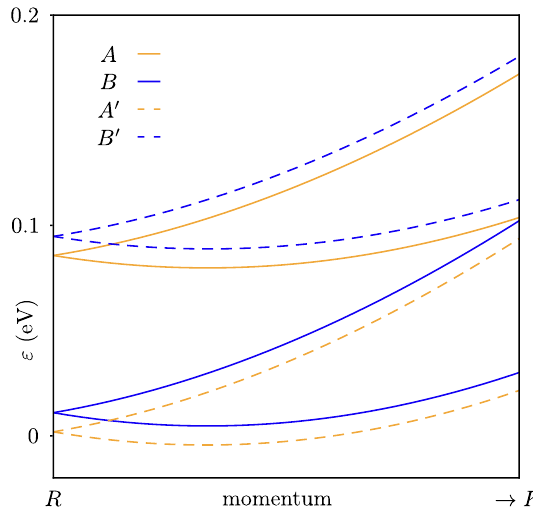
Figure 7: Band structures obtained from the Wannier Hamiltonians corresponding to models A and B , as well as obtained from the modified models, A ′ and B ′ .